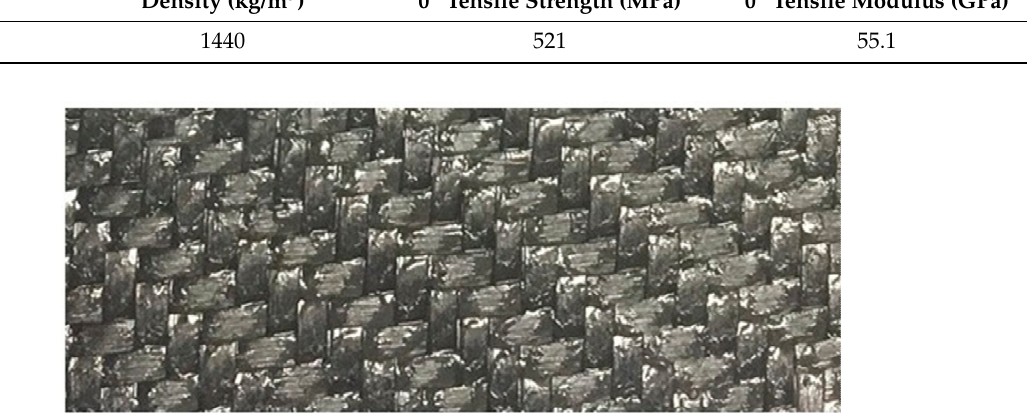
Table 5. Mechanical properties of XPREG ® XC110 (3K) prepreg system